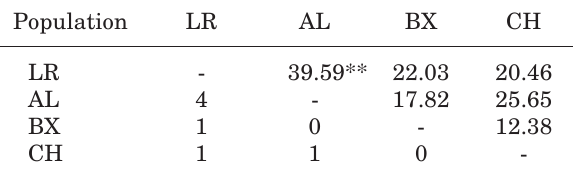
Table 4. Genetic differentiation among regional popula- tions of Eutypa lata collected in Languedoc-Roussillon (LR), Alsace (AL), Bordelais (BX) and Charentes (CH). The global likelihood ratio chi-square (G 2 ) a is given above the diagonal and the number of RAPDs for which a sig- nificant difference in allele frequency exists below the diagonal.